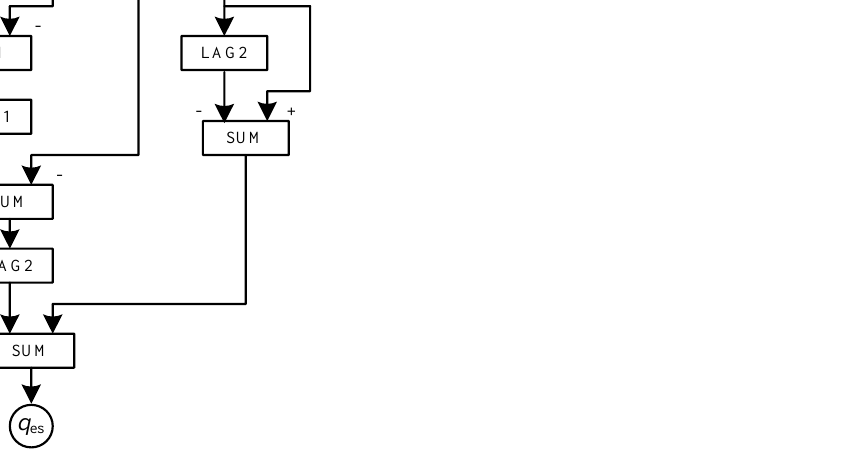
Figure 3. Logic configuration in DCS of the signal fusion parts of soft sensor.